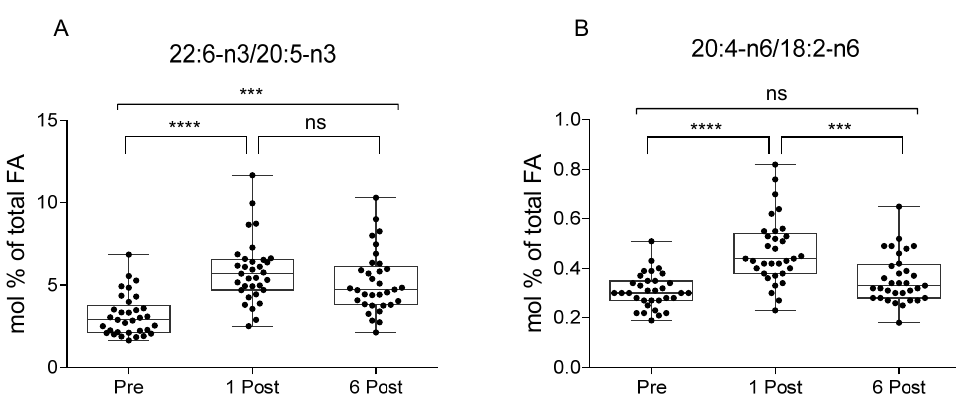
Figure 4. Ratios of 22:6-n3/20:5-n3 ( A ) [ 31,33 ], and 20:4-n6/18:2-n6 ( B ) [ 36] in subjects at baseline (Pre), one month (1 Post) and six months (6 Post) after bariatric surgery. Values, expressed as mol % of total fatty acid (FA), are presented as boxes (mean value) and whiskers (higher and lower values) ( n = 33). *** p < 0.001; **** p < 0.0001.